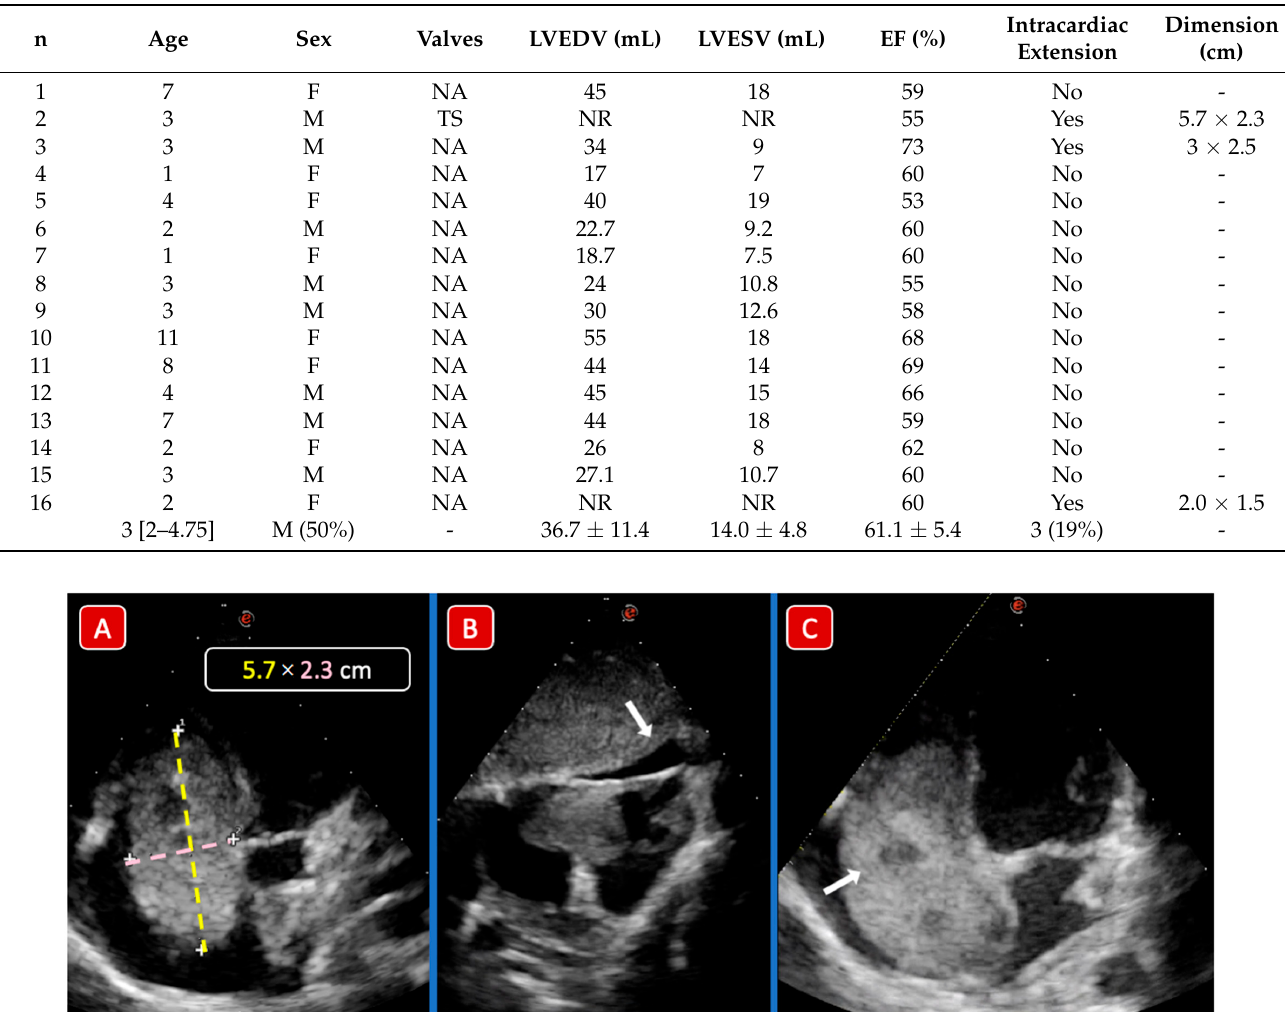
(Figure 1), involving the tricuspid valve annulus, causing a “functional” tricuspid stenosis (Figure 2). The patient died of cardiogenic shock 7 days after admission before he could start chemotherapy and surgical treatment. Table 1. Clinical and echocardiographic characteristics of 16 consecutive young patients with Wilms tumor (WT) admitted to the children’s ward. Abbreviations: LVEDV: left ventricle end diastolic volume; LVESV: left ventricle end systolic volume; EF: ejection fraction; TS: tricuspid stenosis; NA: not affected; NR: not reported. Average data (continuous variables) and prevalence data (dichotomous variables) are reported in the bottom line.